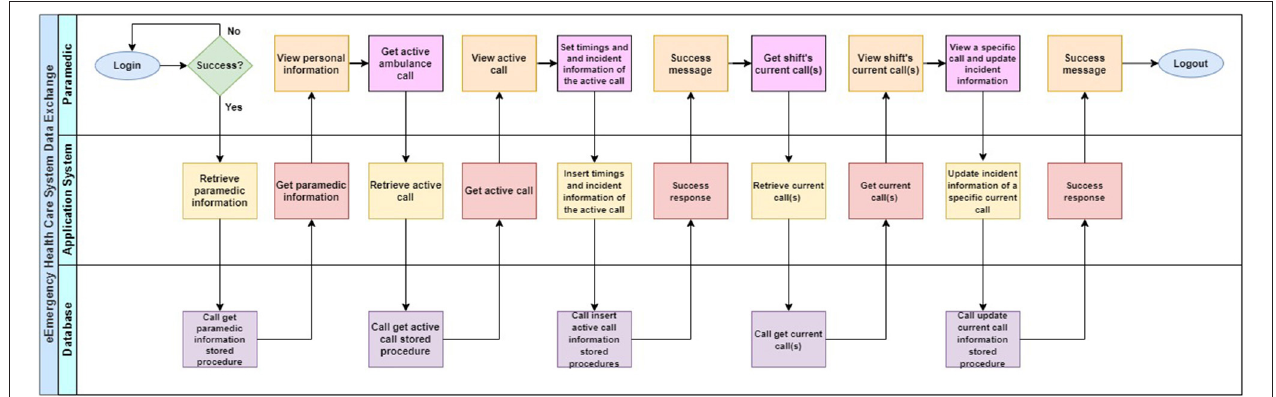
FIGURE 4 | eEmergency health care system data exchange swim lane